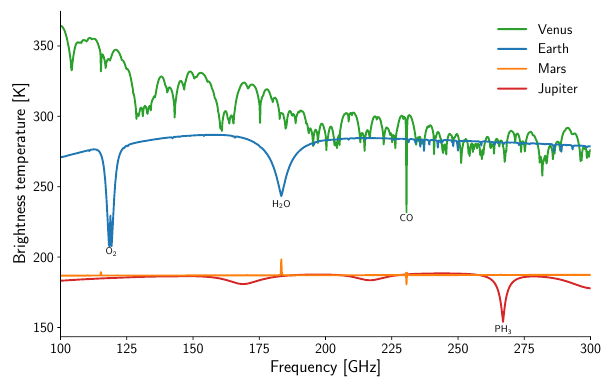
Figure 1. Simulated millimeter-wave nadir observations from space for four different planets. The atmospheric scenarios are the same as the ones underlying Table 2 (vertical profiles, although the table just lists the data for a single pressure level). Surface reflectivity was assumed to be 0.4 for Earth and 0.13 for Mars and does not play a role for the other two planets. The large spectral variability for Venus is caused by SO 2